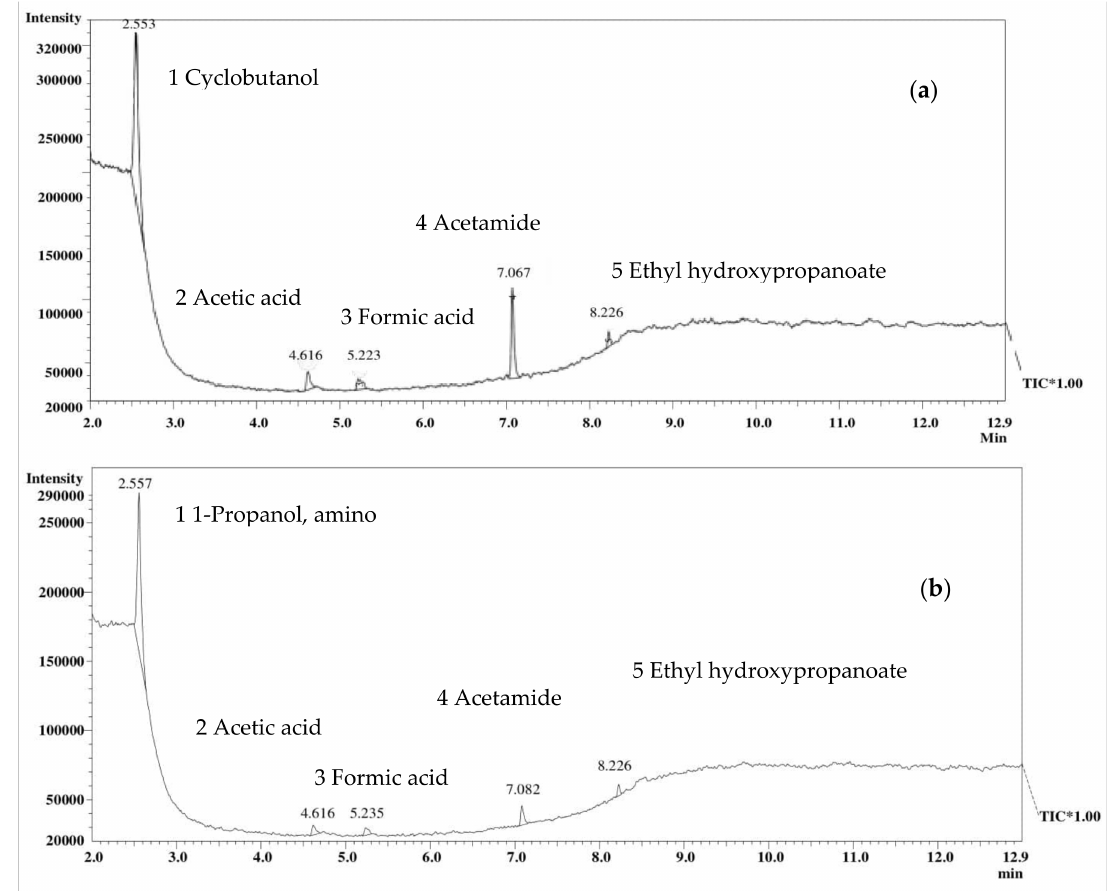
Figure 2. Total ion chromatogram of the water extract EBN of ( a ) half cup and ( b ) stripe-shaped analyzed with